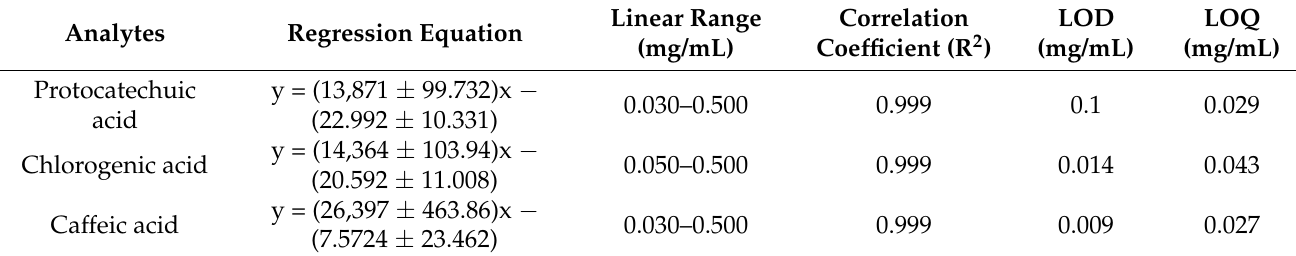
Table 1. Calibration curves, linearity, limits of detection (LOD) and limits of quantification (LOQ). Analytes